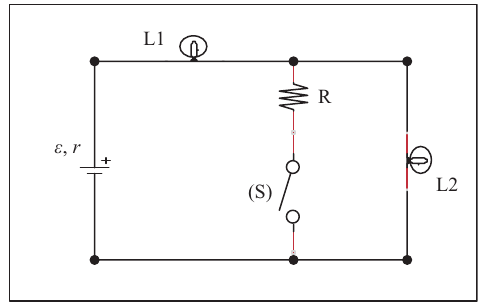
Fig. 4. The brightness of the